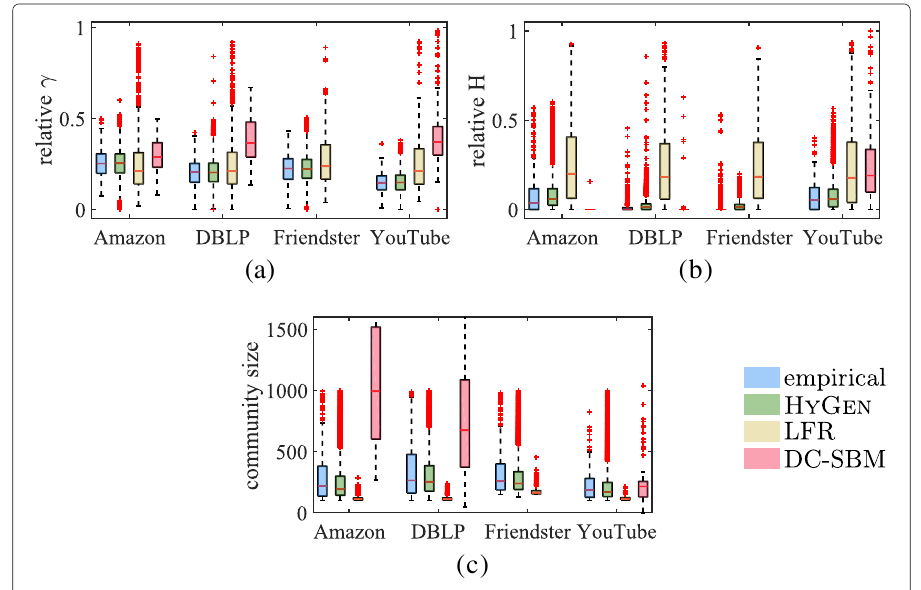
Fig. 7 Distributions of parameters in generated graphs compared to the empirical distributions observed in the original data. H and γ are obtained after fitting hyperbolic models. a γ R b H R c community size (data for DC-SBM > 1600 not